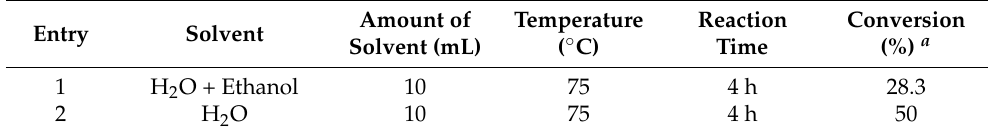
Figure 5. Schematic diagram of flow system for L- α -GPC synthesis. Table 4. Reaction conditions and conversions of second reaction step using different solvents in a flow